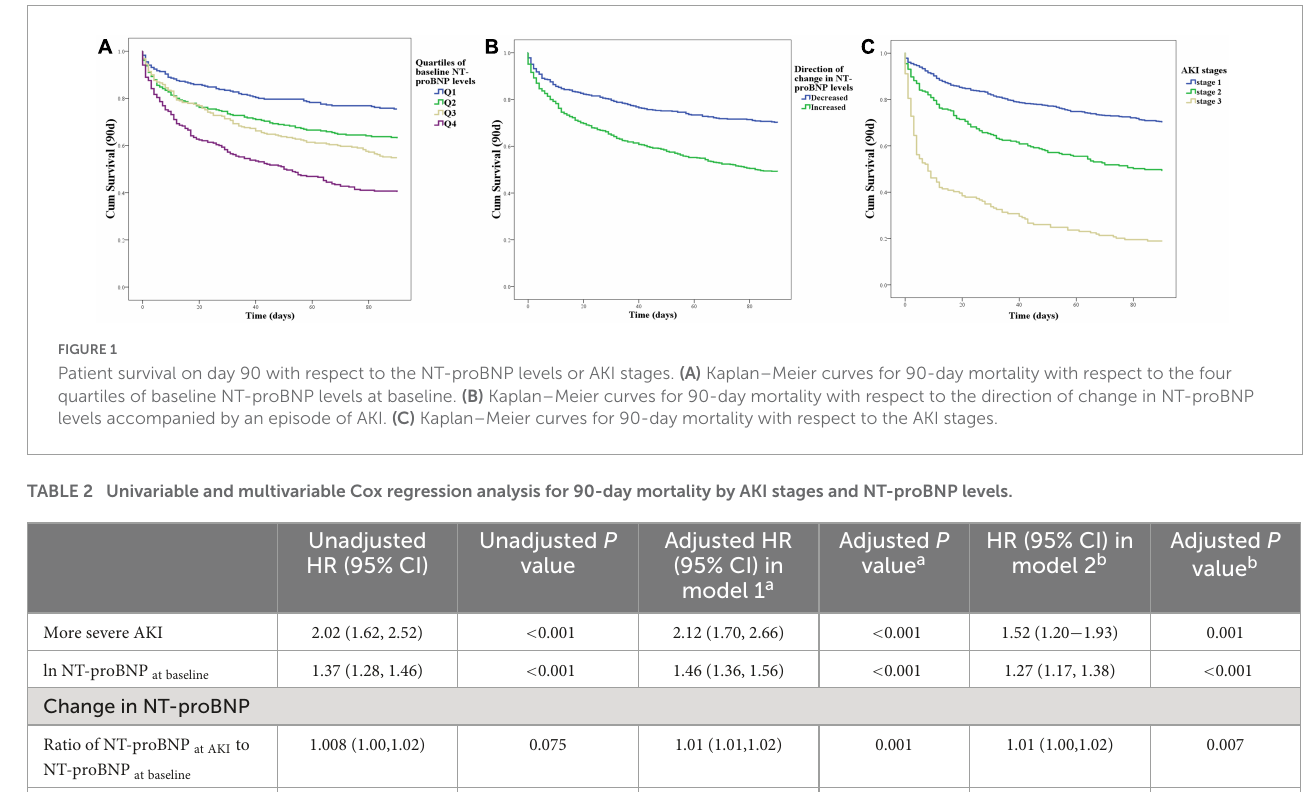
TABLE 3 Univariable and multivariable logistic regression analysis for 90-day renal non-recovery by AKI stages and NT-proBNP levels.